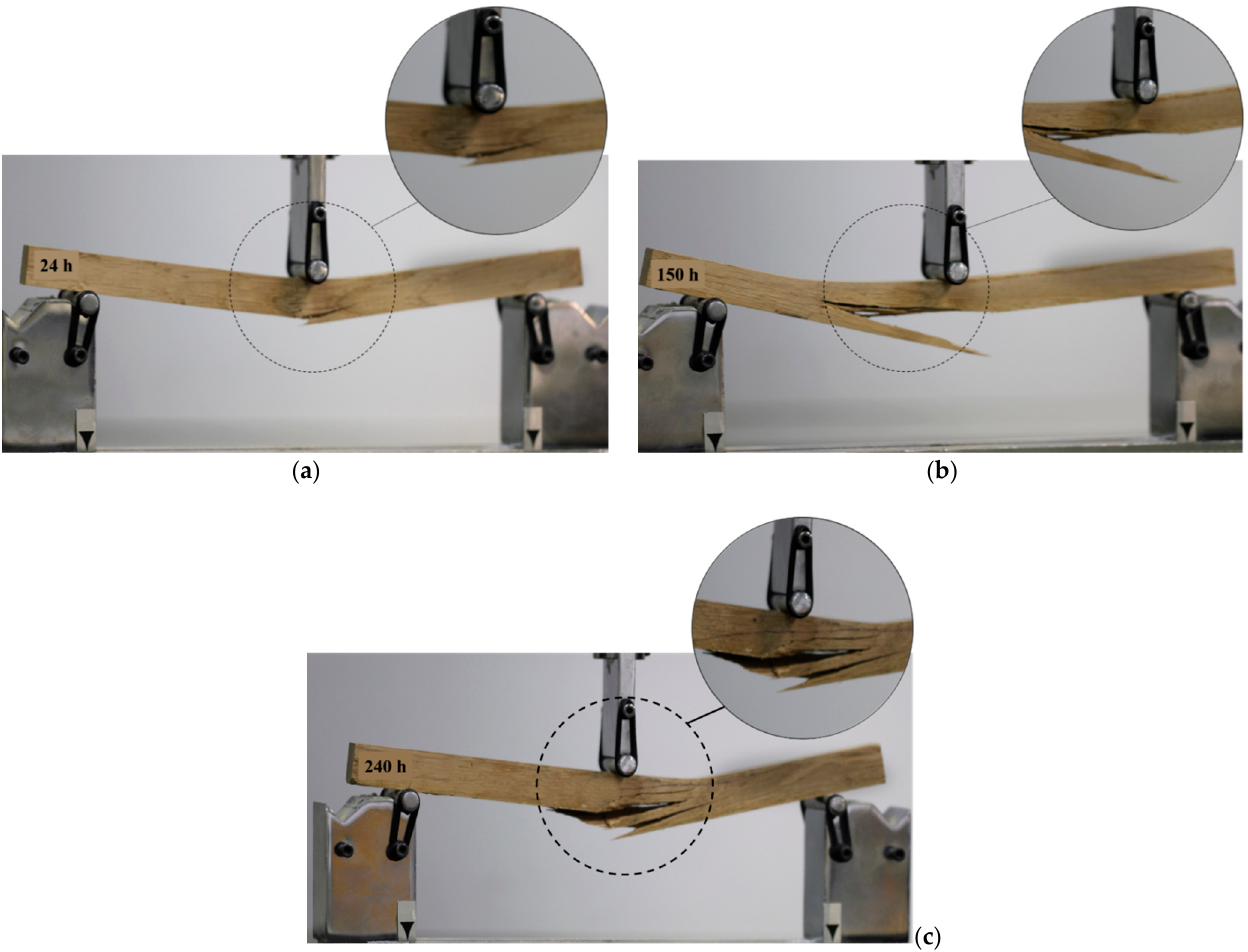
Figure 5. The fracture plane of the weathered oak wood at three exposure times: 24 h ( a ), 150 h ( b ), and 240 h ( c ) under the static bending test.